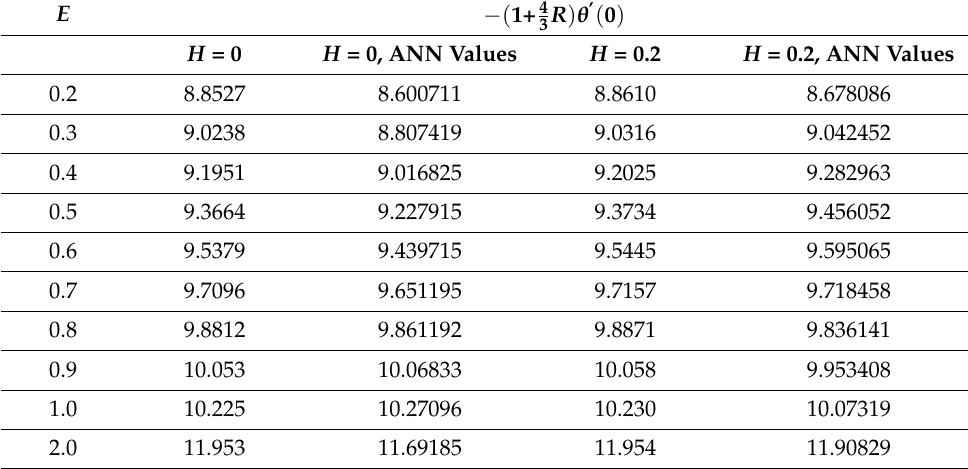
Table 2. Impact of Eckert number on Nusselt number with and without heat generation.